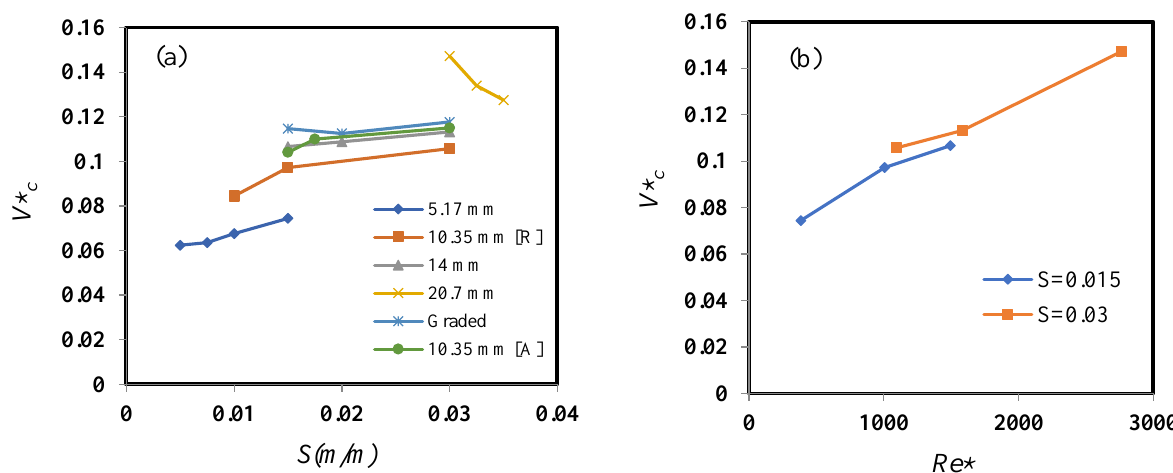
Figure 2. Critical shear velocity as a function of bed slope ( a ) and grain Reynolds number ( b ).